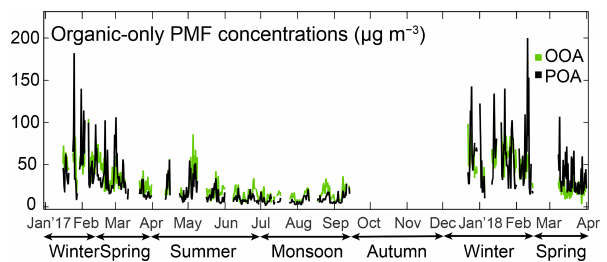
Figure 2. The 12h averaged concentration time series (TS) of organic-only PMF oxygenated organic aerosol (OOA) factor and primary organic aerosol (POA) factor (µgm − 3 ). Factor concentra- tions show strong seasonal